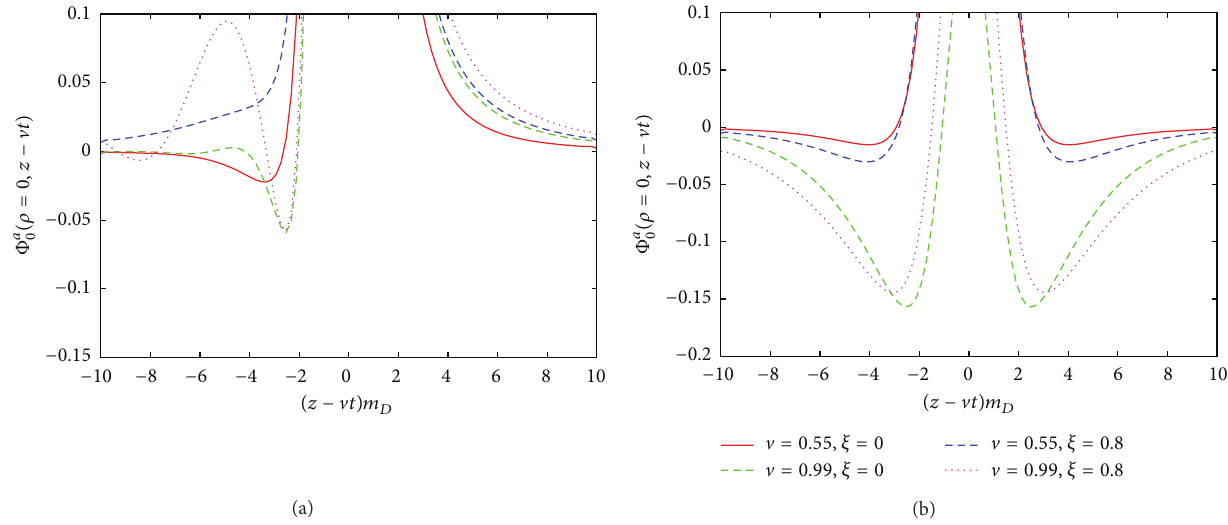
Figure 12: (Color online) (a): scaled wake potential along the motion of the fast parton, that is, 𝑧 -axis for different 𝜉 with two different parton velocity V = 0.55 and V = 0.99 . (b) same as (a) but perpendicular to direction of motion of the parton.